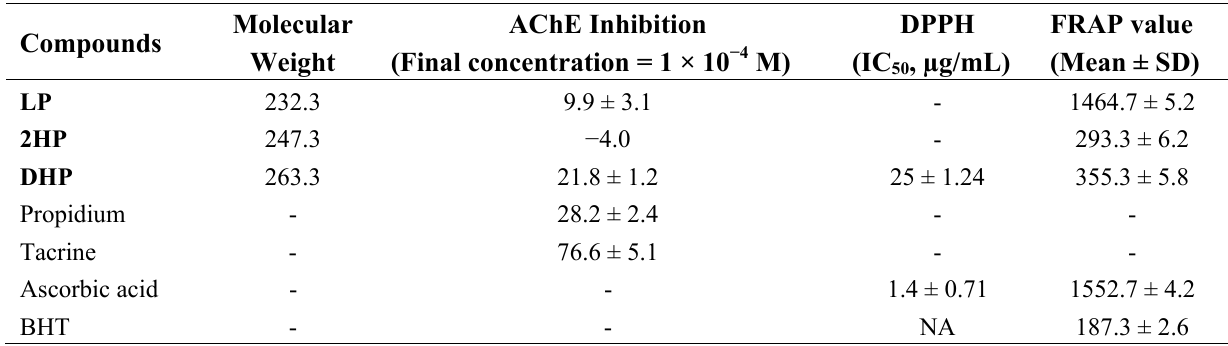
Table 1. Human AChE inhibitory effects and anti-oxidant activities of LP , 2HP and DHP .